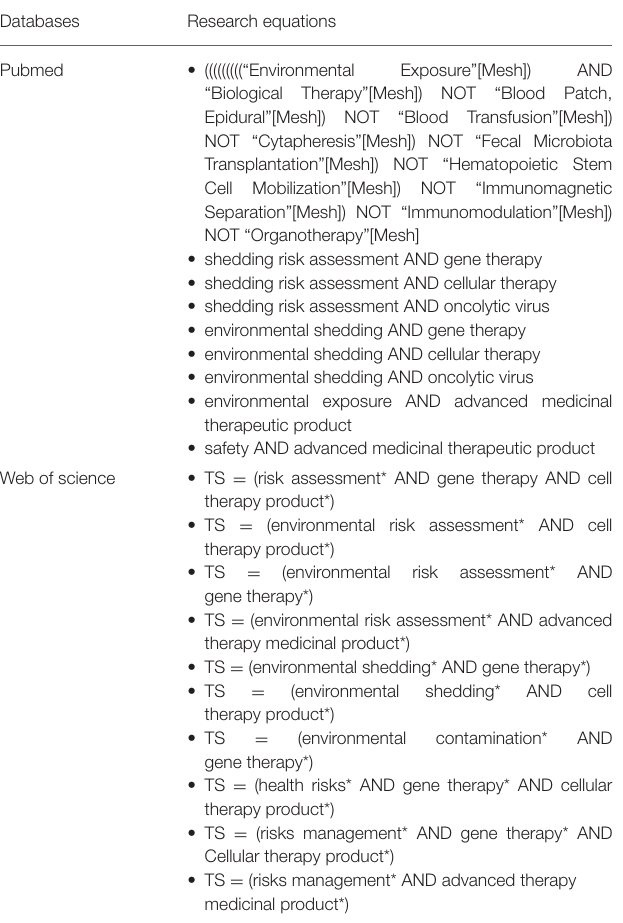
TABLE 1 | The keywords and MeSH terms to conduct the literature search.